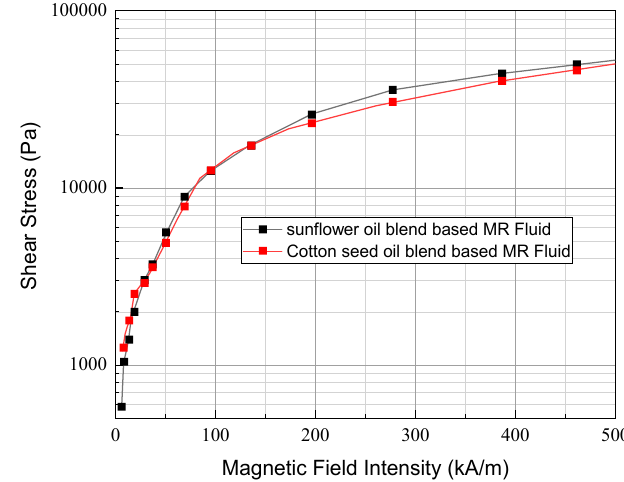
Figure 6. Shear stress as a function of a variable magnetic field for the organic oil blend-based MR fluids.